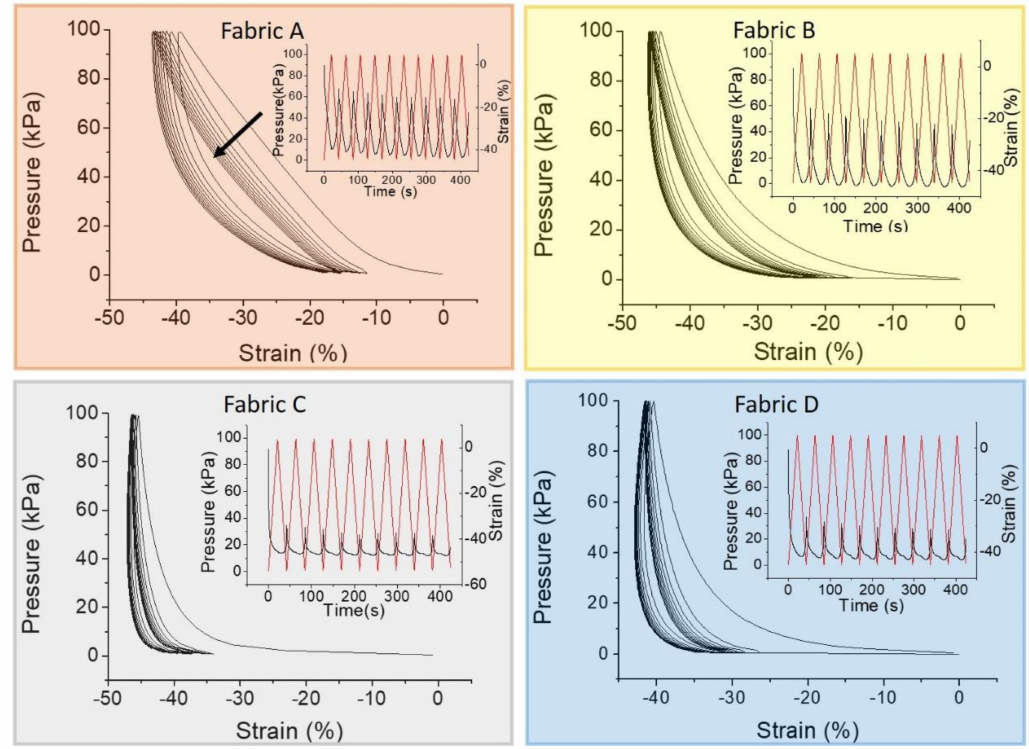
Figure 4. Stress-strain curve of fabrics: the arrow indicates the curve shift direction from the first to the tenth cycle. Inset: pressure (black line) and strain (red line) as a function of time for each